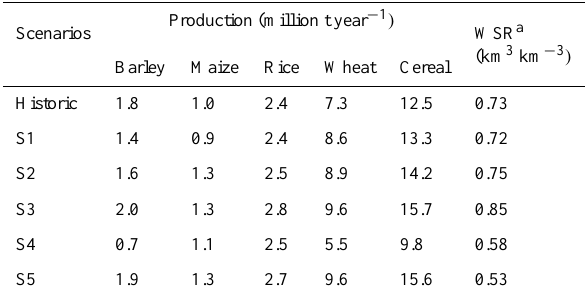
Table 4. Irrigated cereal production and water scarcity ratio at na- tional level averaged over 1990–2004 for historic and scenario re-